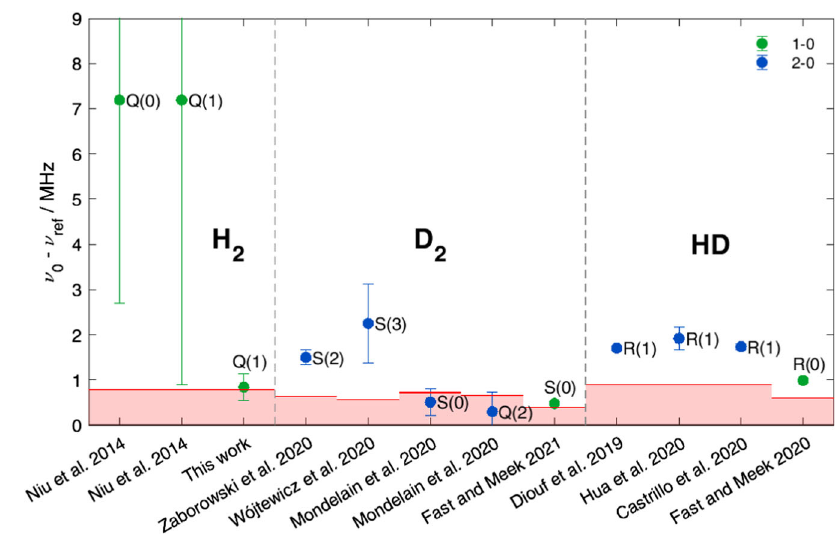
Fig. 4 Comparison of experiment and theory for various rovibrational transitions of H 2 isotopologs. Data points represent the discrepancy on the transition frequency (experiment – theory), with error bars given by the experimental uncertainty (1 σ ) and the height of the red shaded area at the bottom representing the theoretical uncertainty. Line names are reported next to data points, while the rovibrational band is identi fi ed through the point color (see legend). The data point corresponding to this work summarizes 10 measurement series acquired over 5